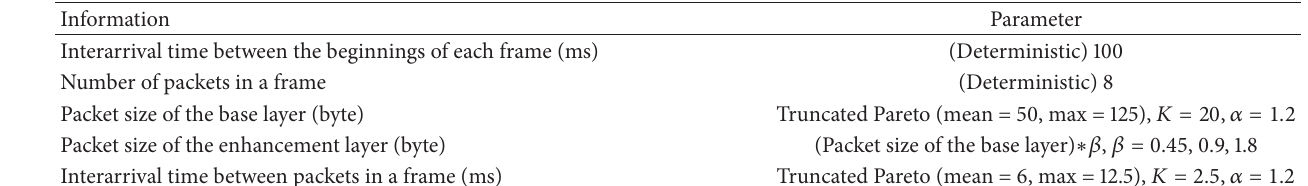
Table 2: Parameters of the 3D A/V traffic model.